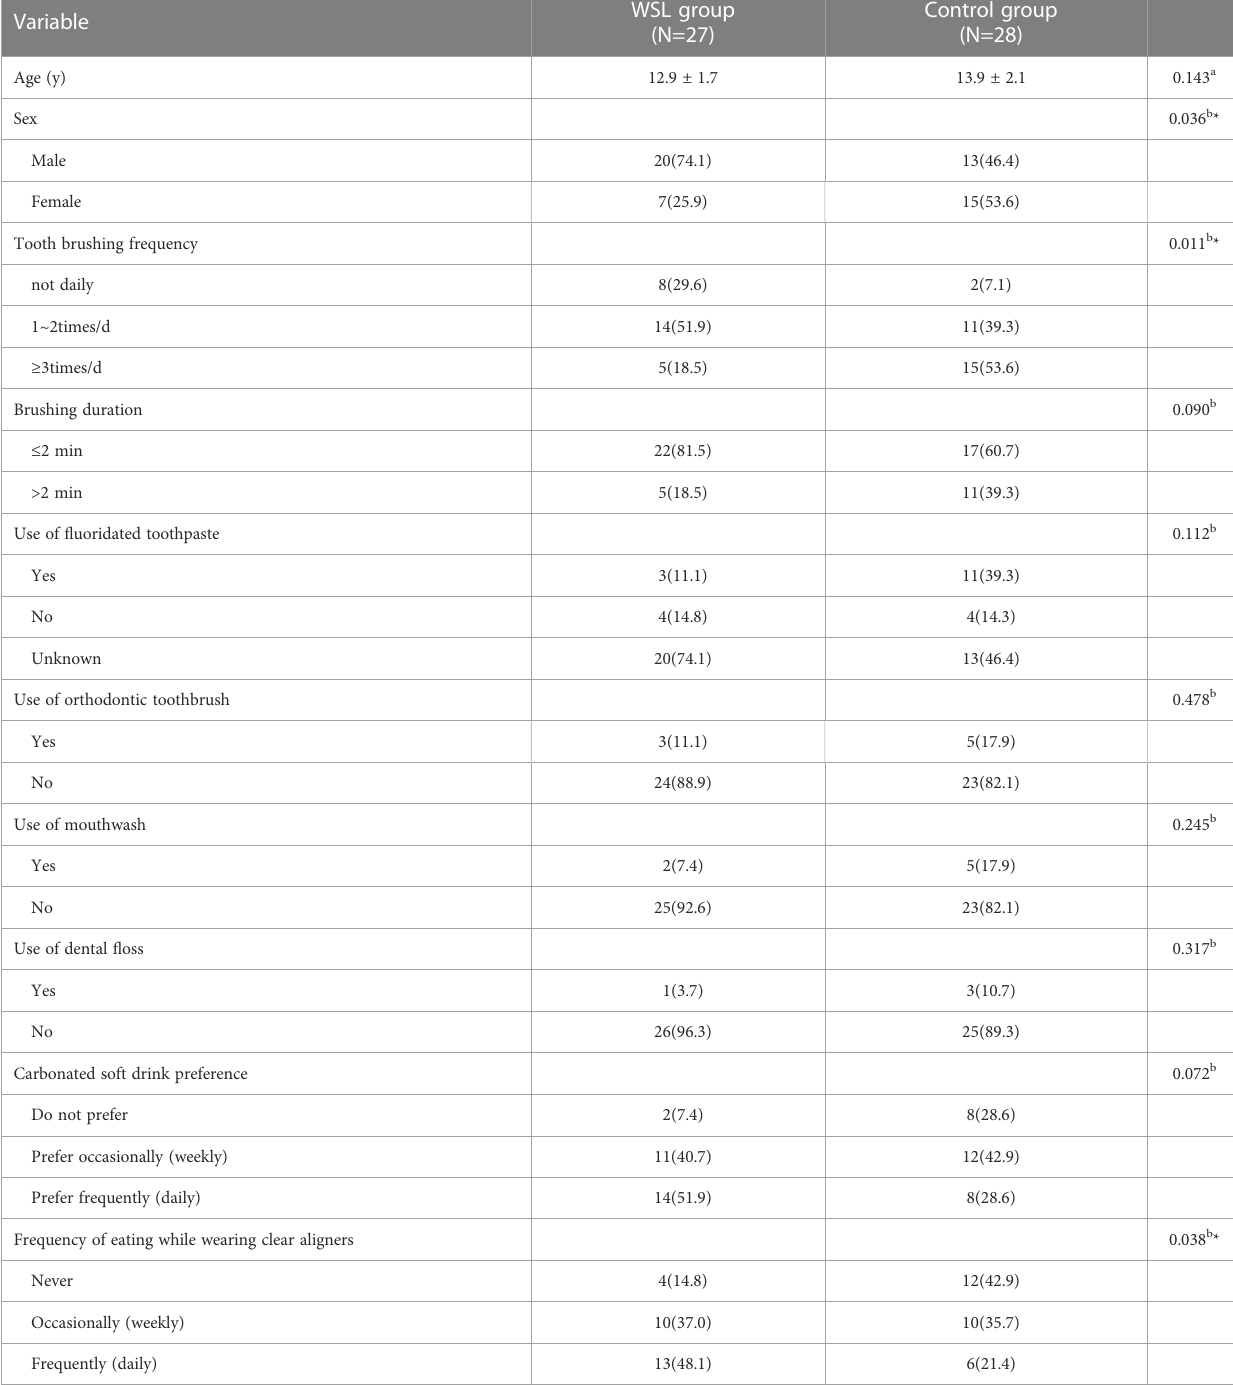
TABLE 1 Demographics and Behavioral Characteristics of the Study